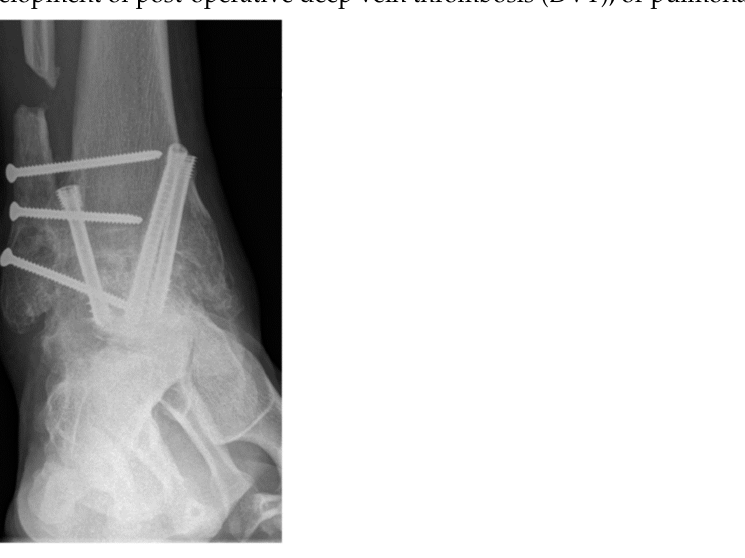
Figure 3. A 57-year-old male patient presenting complete union of the tibiotar and distal tibiofibular joints at 6 months follow-up.